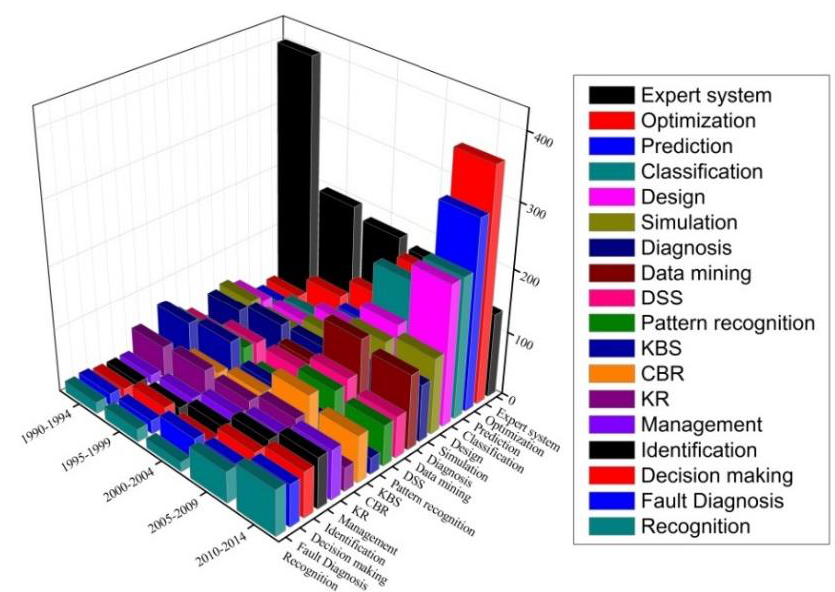
Figure 6. Trends of keywords with respect to method and model.